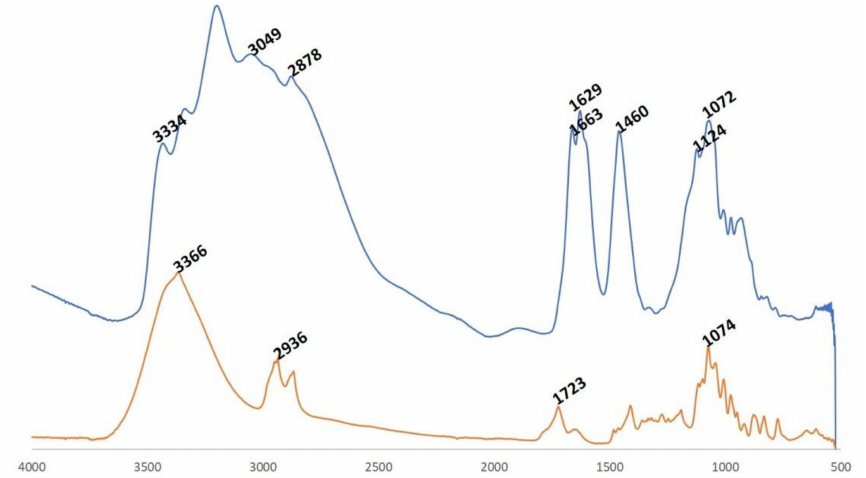
Figure 2. FT-IR spectra of isosorbide (orange) and modified isosorbide